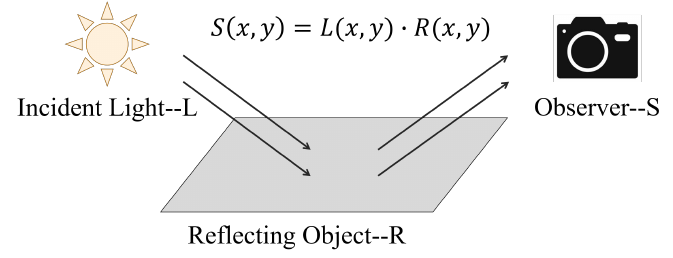
Figure 3. Composition of images in Retinex